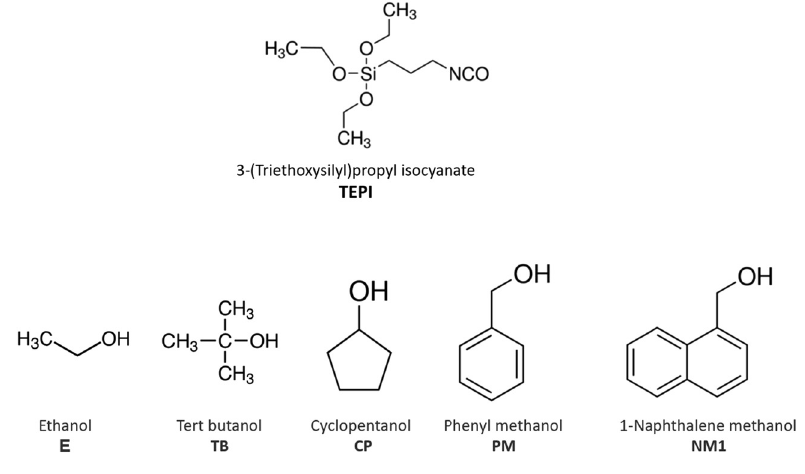
Figure 2: Chemical structures of the selected silane and alcohols.